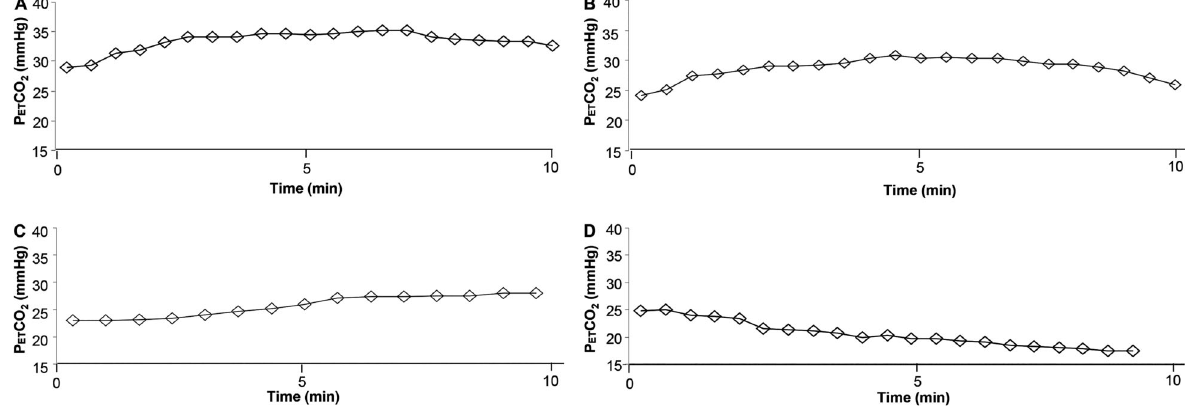
Figure 2. End-tidal CO 2 pressure (P ET CO 2 ) response during incremental exercise test in 4 patients with chronic heart failure of progressive severity. Panel A , A 69-year-old male patient with dilated cardiomyopathy (left ejection fraction: 60%; peak oxygen consumption (VO 2 ): 23.7 mL (cid:3) kg – 1 (cid:3) min – 1 ; VE/VCO 2 slope (rest-peak): 33.0). P ET CO 2 at rest was 29.0 mmHg and change in P ET CO 2 from rest to the highest value attained during exercise ( D P ET CO 2 rest-exercise) was 6.3 mmHg. Panel B , A 58-year-old male patient with ischemic heart failure (left ejection fraction: 42%; peak VO 2 : 19.0 mL (cid:3) kg – 1 (cid:3) min – 1 ; VE/VCO 2 slope (rest-peak): 40.5). P ET CO 2 at rest was 25.1 mmHg and D P